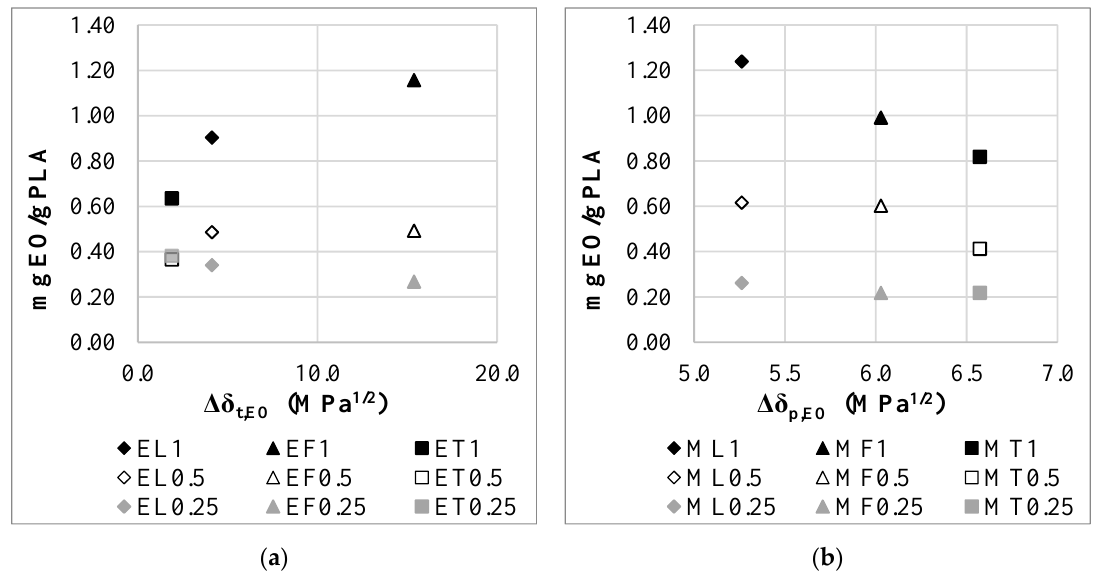
Figure 10. Correlation between the HSP parameters and the specific essential oil uptake in the case of ( a ) ethanol solutions; ( b ) methanol solutions.